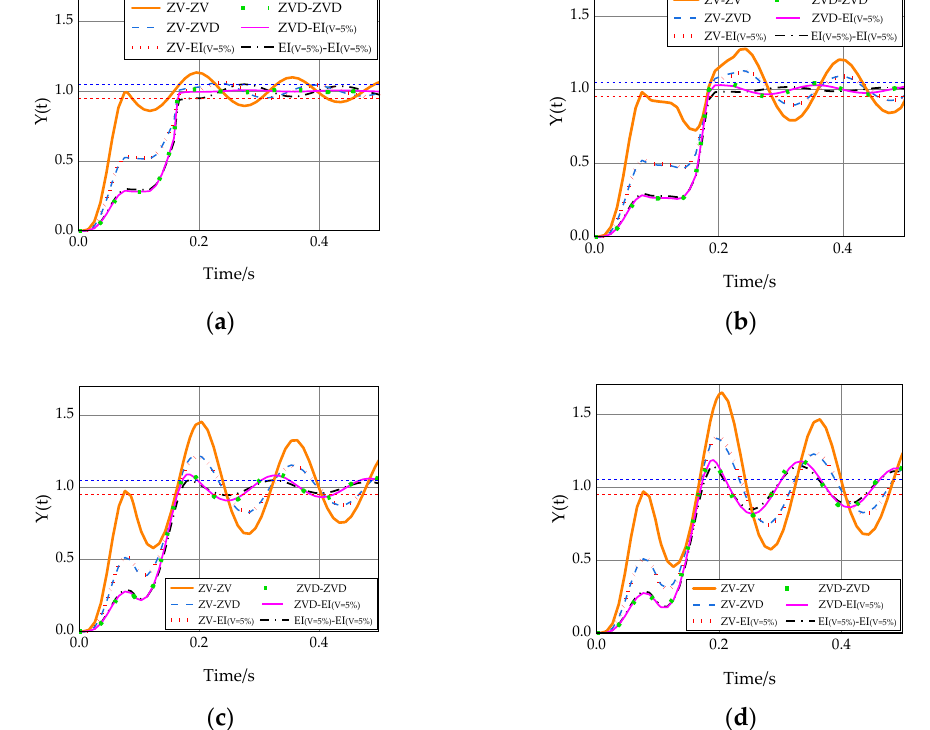
Figure 15. Unit step response of each dual-modal input shaper when the system modal parameters have error values: ( a ) response when the system modal parameter error value is 5%; ( b ) response when the system modal parameter error value is 10%; ( c ) response when the system modal parameter error value is 15%; ( d ) response when the system modal parameter error value is